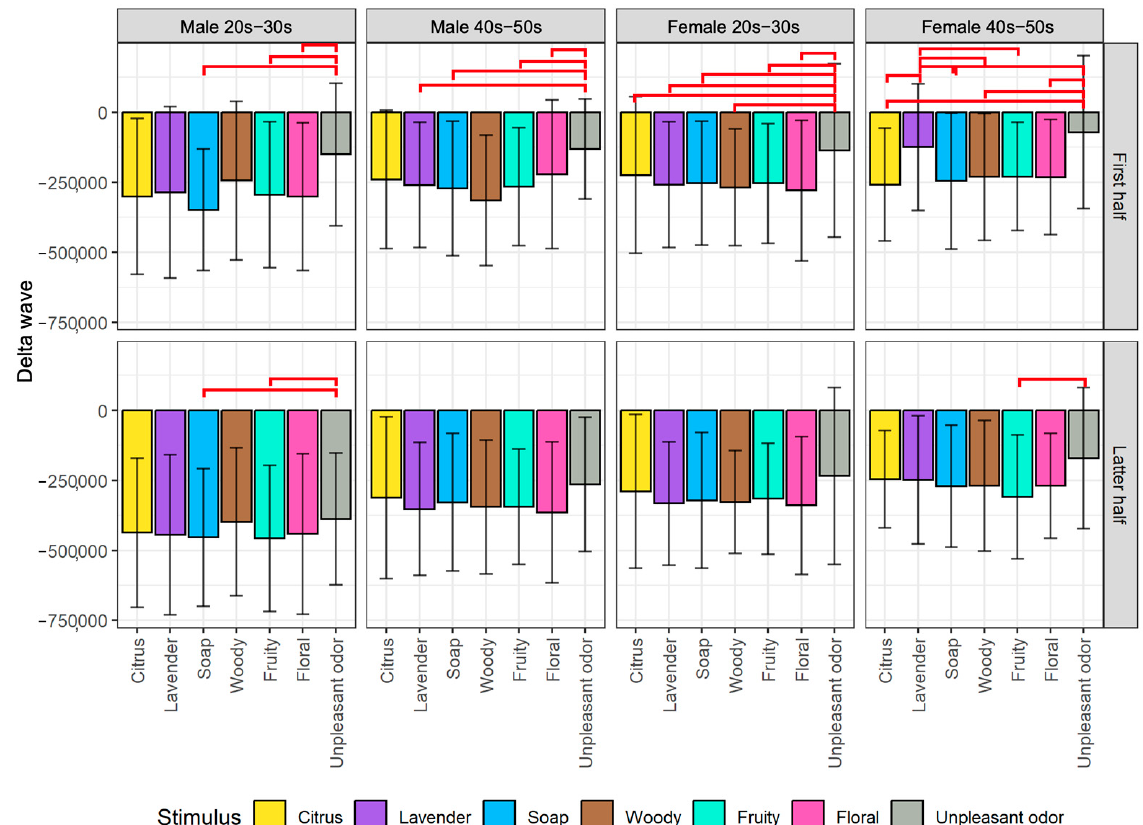
Figure 7. Comparison of changes in δ wave among stimuli by gender and generation groups divided into the first half (top) and latter half (bottom) of stimulus exposure time. The red lines indicate signi fi cant di ff erences between pairs of stimuli.